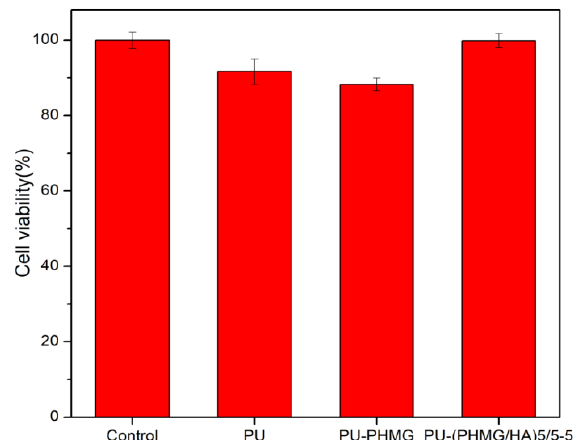
Figure 7. Cell viability of L929 after being cultured in PU, PU-PHMG, and PU-(PHMG/HA) 5 /5-5 extracts.